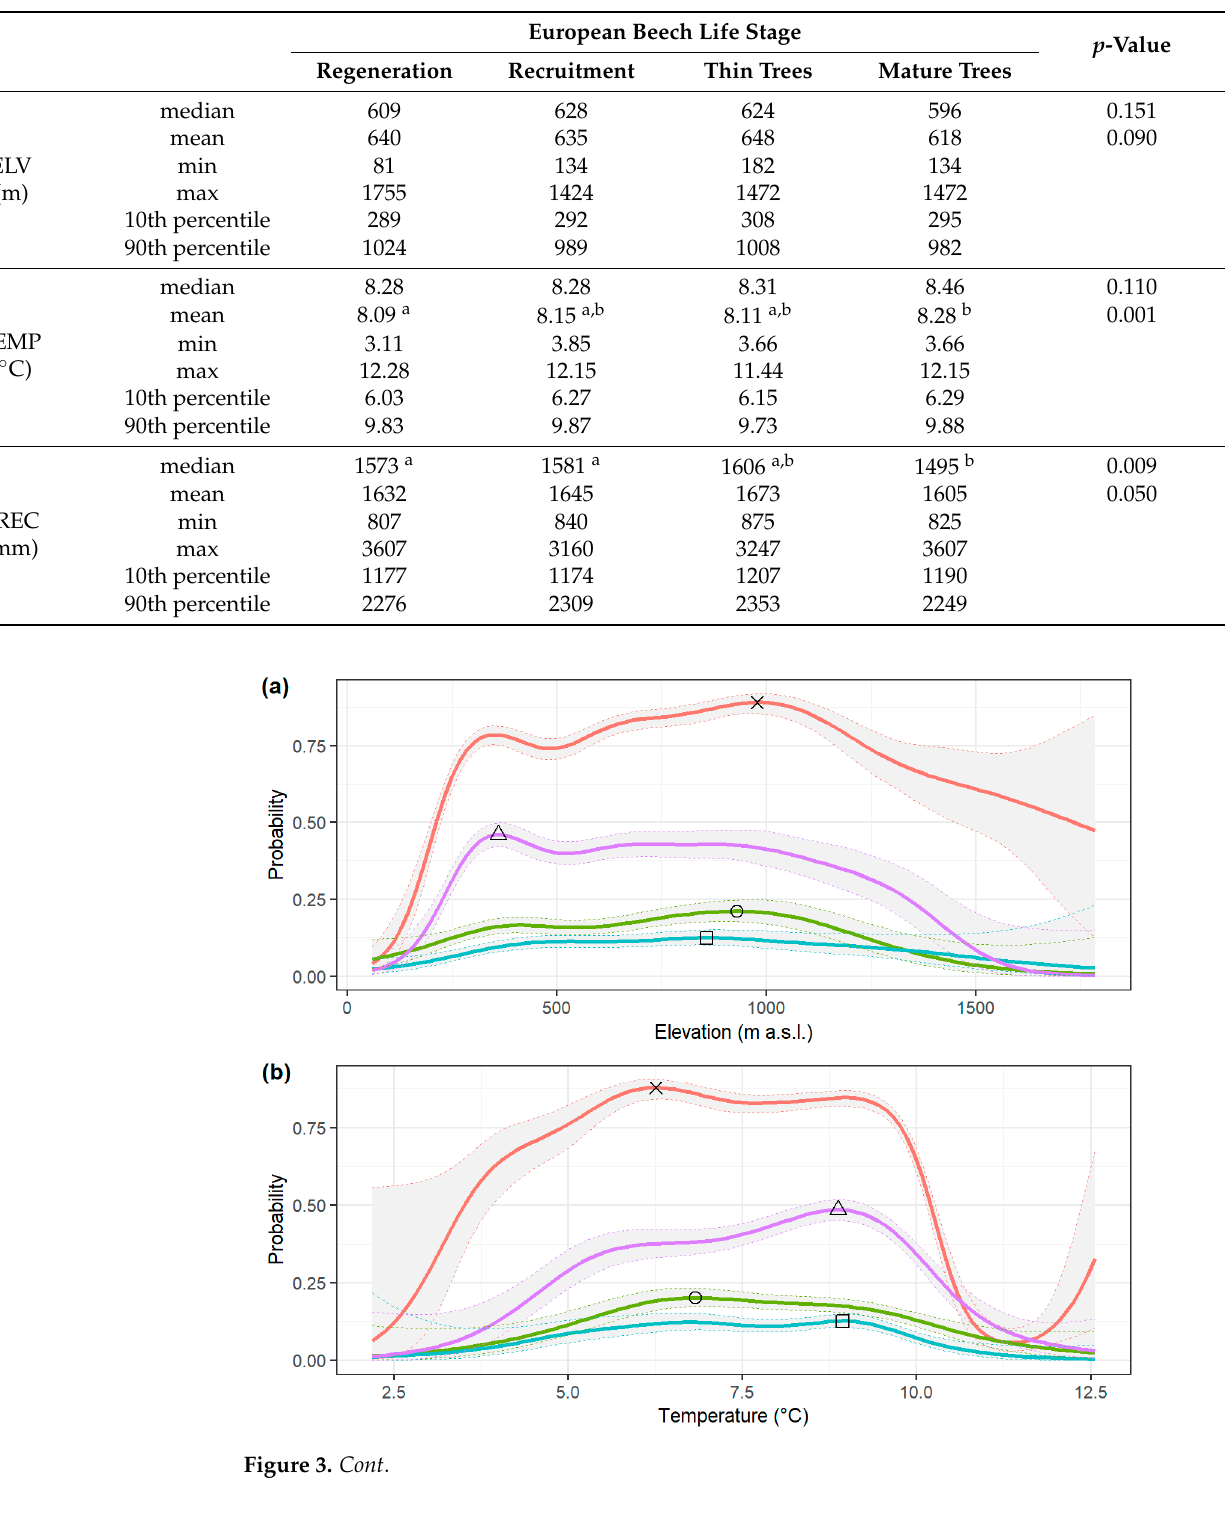
Figure 3. Elevation ( a ), temperature ( b ) and precipitation ( c ) response curves derived with GAM models per life stages of the European beech; the optimums are highlighted by marks related to the life stage. The ELV probability response curves signified differences in the optimum ELV (i.e., ELV exhibiting maximum probability for occurrence) for beech life stage occurrence. The optimum ELV for regeneration, recruitment, young trees and mature trees amounted to 978 m, 929 m, 858 m and 360 m a.s.l., respectively (Figure 3). The response curves for regeneration and mature trees were of similar bimodal shape, but with two local maxi- mums at different ELV. For regeneration and mature trees, the first local maximums were at 352 and 360 m a.s.l., respectively, and the second at 978 and 714 m a.s.l., respectively. The maximum abundance of beech regeneration, however, was, in contrast to its occur- rence probability, much lower at 340 m a.s.l. (Figure 4). Similarly, the maximum abun- dance of mature trees was at 354 m a.s.l., while the maximum abundance of recruitment and thin trees appeared at higher elevations.